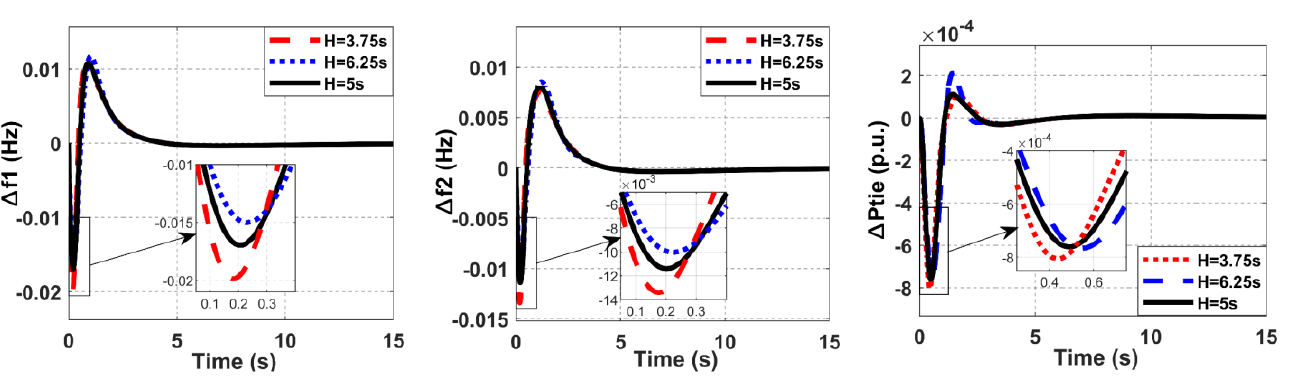
Figure 16. The dynamic response of the power system under different inertia constant (75% and 125% of the nominal value H = 5 s).